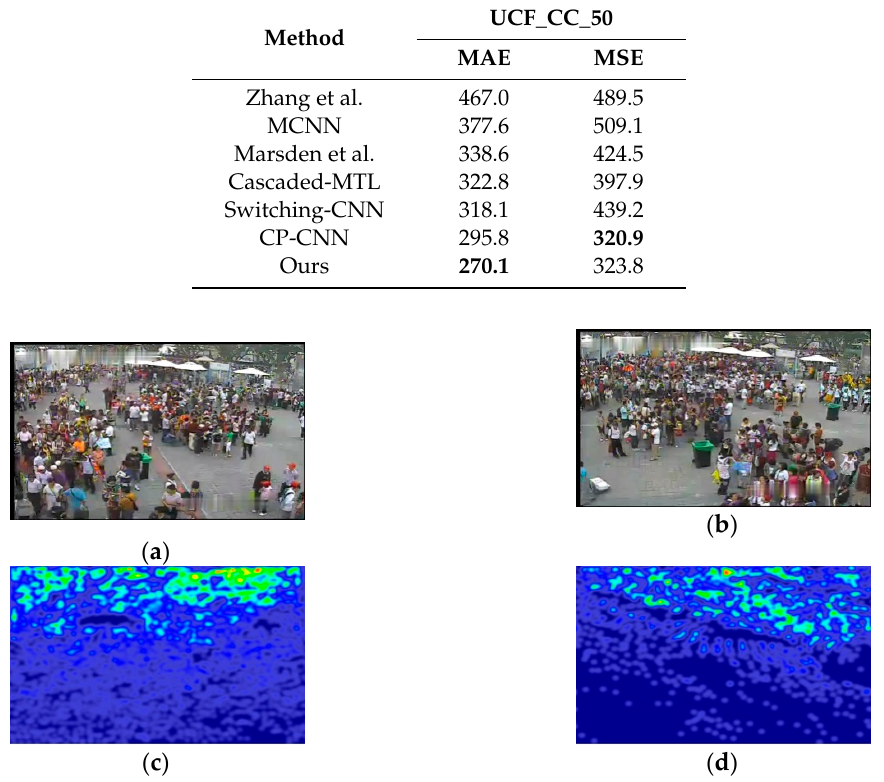
Figure 8. Two sample images in WorldExpo’10 dataset. ( a , b ) are two sample images in WorldExpo’10 dataset. ( c , d ) are their density map generated by DSA-CNN for two images, respectively.